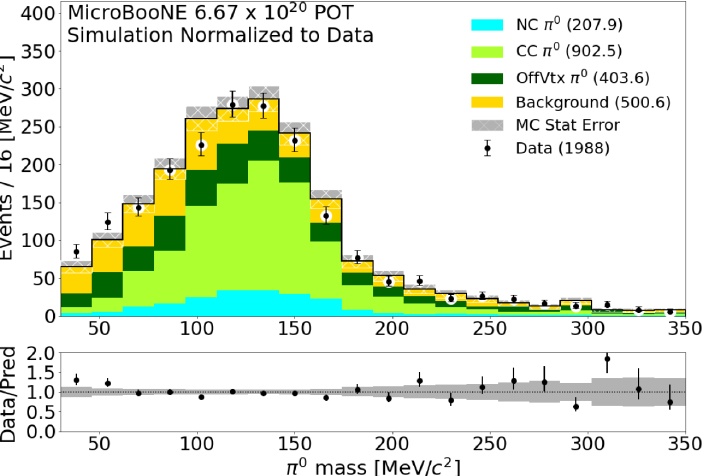
Figure 9. Total reconstructed neutral pion mass from charged current (CC) events, neutral current (NC) events, and neutrino interaction events off vertex (OffVtx). Statistics in simulation scaled to beam protons on target used for data distribution. Figure originally from